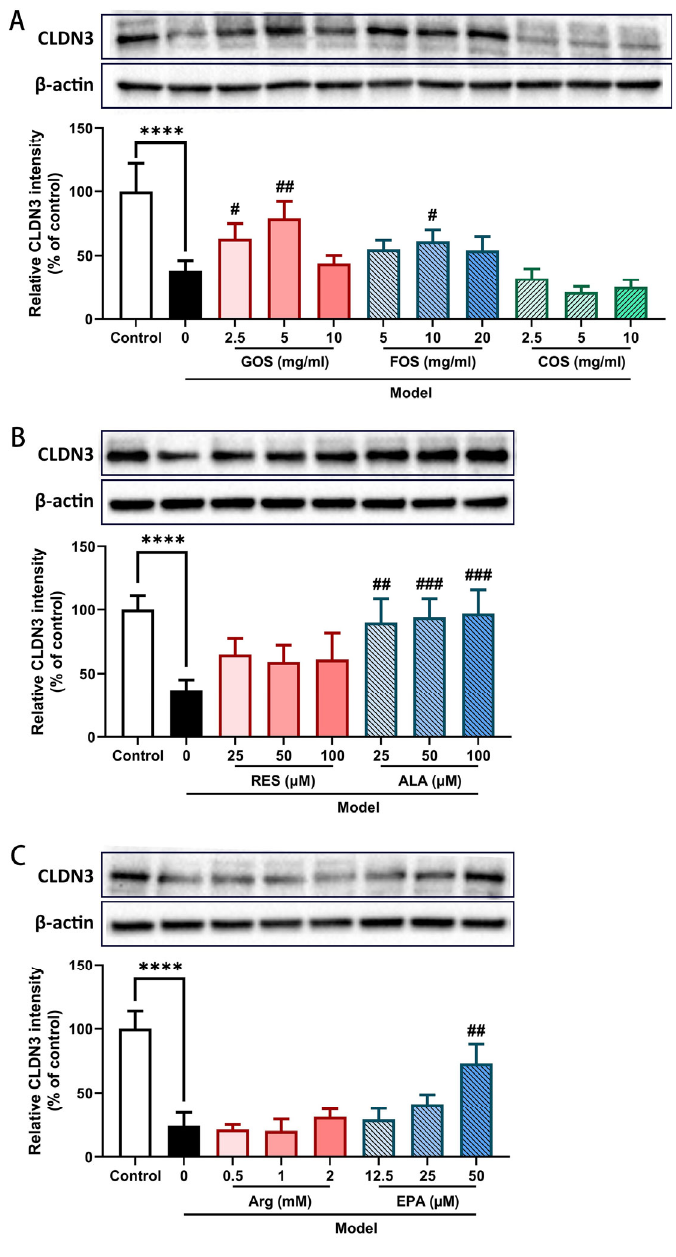
Figure 5. Relative CLDN3 protein expression level in Caco-2/HT-29 cell monolayer pre-incubated with GOS, FOS, COS ( A ), RES, ALA ( B ), Arg, and EPA ( C ) for 48 h then exposed to hypoxia and heat treatment (2 h). CLDN3 protein expression was determined by WB and normalized to β -actin. All values were presented as means ± SEM (N = 3, n = 2 (GOS, FOS, COS group), and n = 3 (all other groups)). Statistical differences were analyzed by two-way ANOVA followed by the Bonferroni’s multiple comparison test. **** p < 0.0001 versus control; # p < 0.05, ## p < 0.01 and ### p < 0.001 versus model. GOS, galacto-oligosaccharides; FOS, fructo-oligosaccharides; COS, chitosan oligosaccharides; ALA, α -lipoic acid; RES, resveratrol; Arg, l-arginine; EPA, eicosapentaenoic acid. The original uncropped bands are included in the Supplementary Materials.